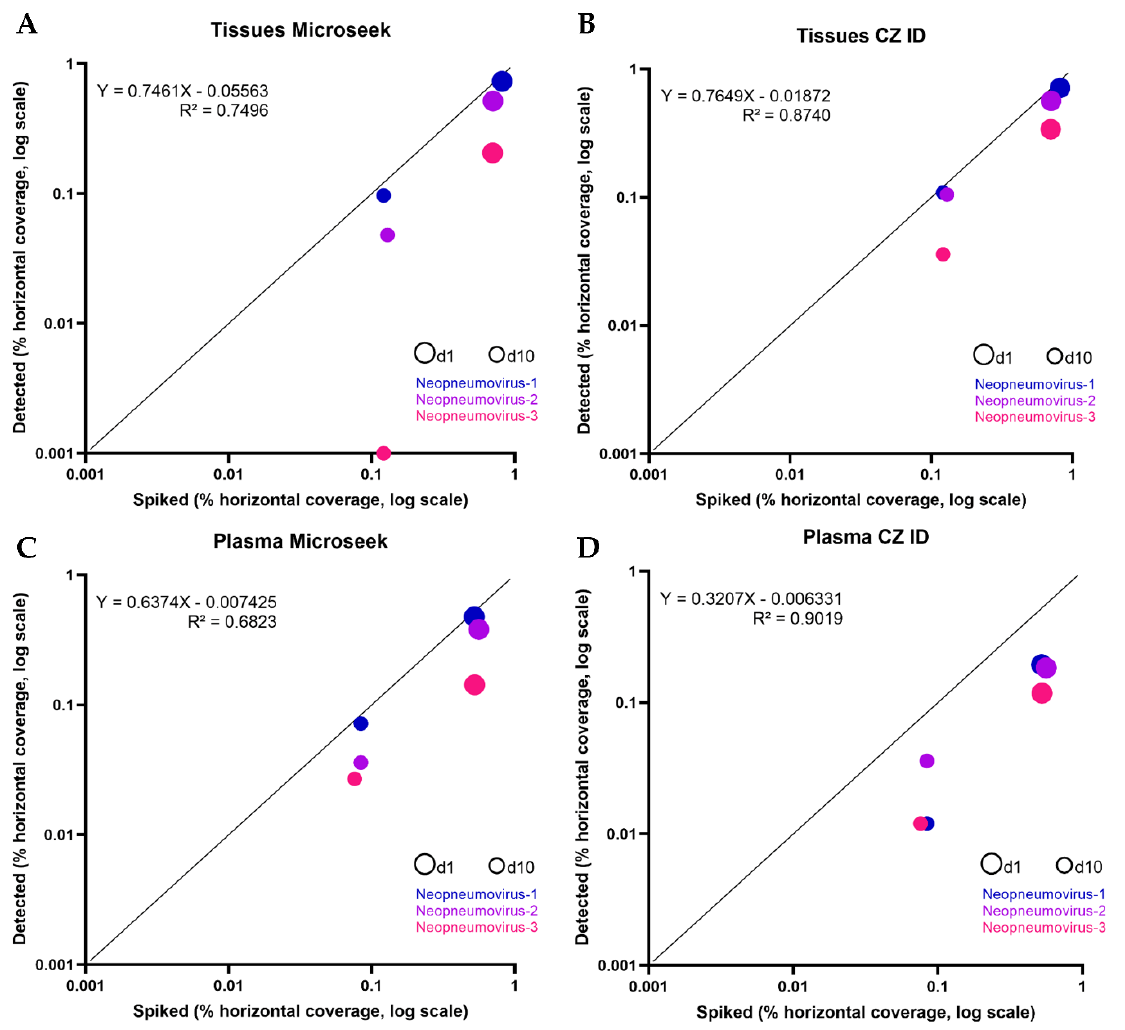
Figure 4. Detection of three Neopneumoviruses (spiked vs. detected). Scatter plots of spiked (X axis) vs. detected (Y axis) percentage horizontal coverage for the 3 fake Neopneumoviruses of the study, for the Tissues ( A , B ) and Plasma ( C , D ) experiments. Each virus is depicted by 2 points, corresponding to the d1 (large circles) and d10 (intermediate circles) experiments, and is associated with a specific color (blue: Neopneumovirus-1; purple: Neopneumovirus-2; pink: Neopneumovirus-3). The identity line (Y = X) is represented in black.